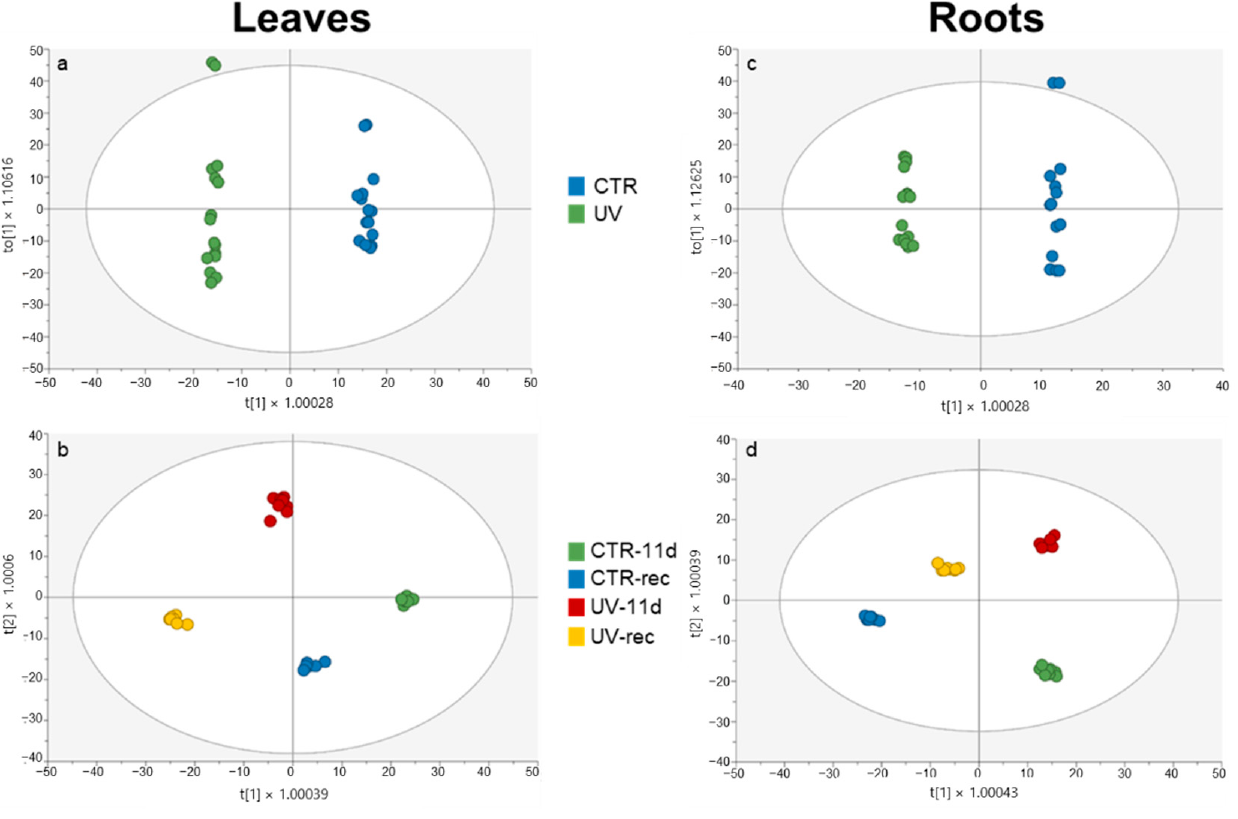
Figure 2. OPLS-DA carried out from the UHPLC-ESI-QTOF metabolome of leaves and roots of Micro-Tom tomato plants, considering ( a , c ) the UV treatment factor; ( b , d ) UV treatment and time factors. Individual replications are given in the class prediction model score plot. Table 1. Leaf metabolic markers, according to their VIP score ± standard deviation (STD), related to the OPLS-DA model in Figure 2a (effect of UV treatment). Compounds are provided with p value and their Log 2 FC calculated with respect to control samples. * p ≤ 0.05, ** p < 0.01, *** p < 0.001, n.s., not